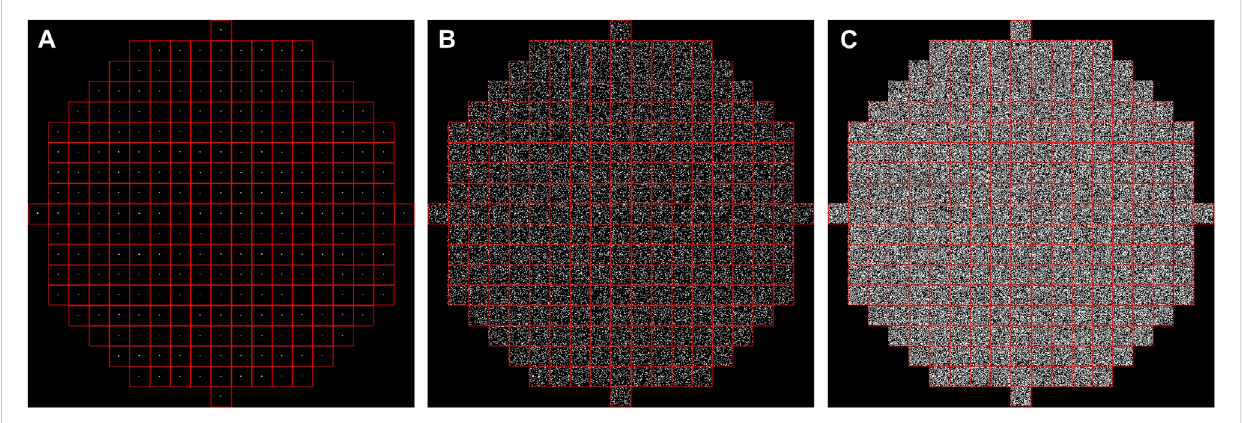
FIGURE 2 The light intensity calculated with the p-SHWFS. (A) no stray light and (B) mixed light with SBR = 6.29 dB and (C) SBR = 15.03 dB.